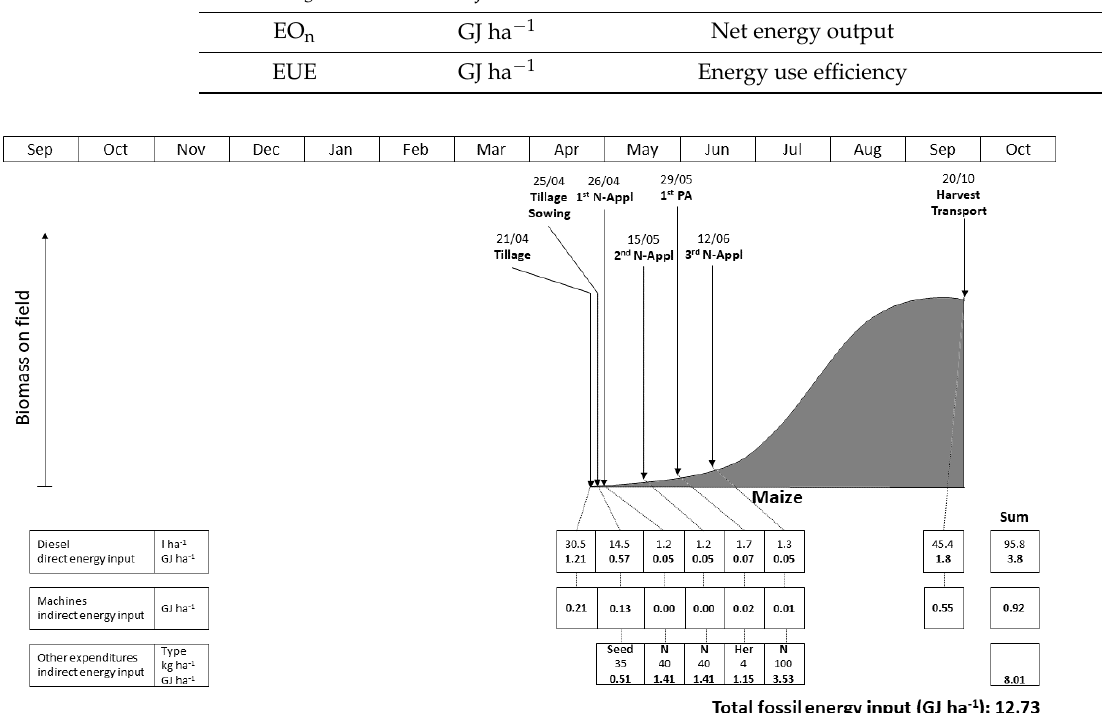
Figure 1. Field operations, resource expenditures, and affiliated energy inputs across the growing season of maize. Schematic following [50]. N-Appl: mineral nitrogen application, PA: pesticide application, Her: herbicide.